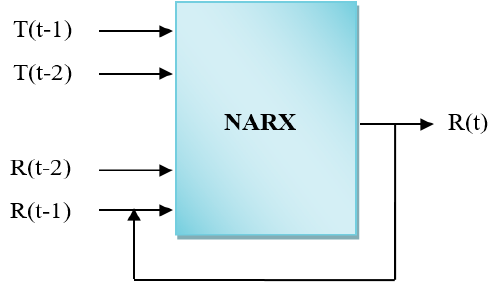
Figure 28. NARX model architecture.